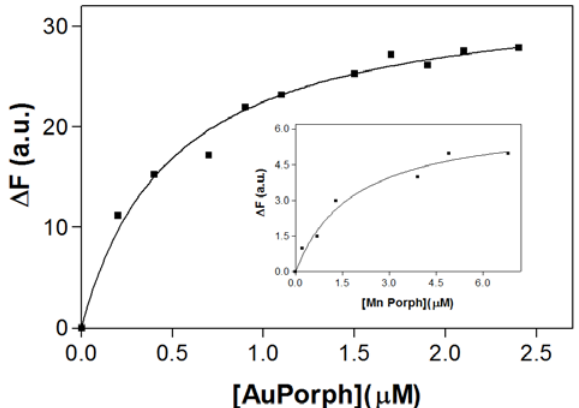
Fig. 1. Interaction of Con A with AuTPPS and MnTMPyP (inset). The curves are the best theoretical fits of the analyzed experimental data